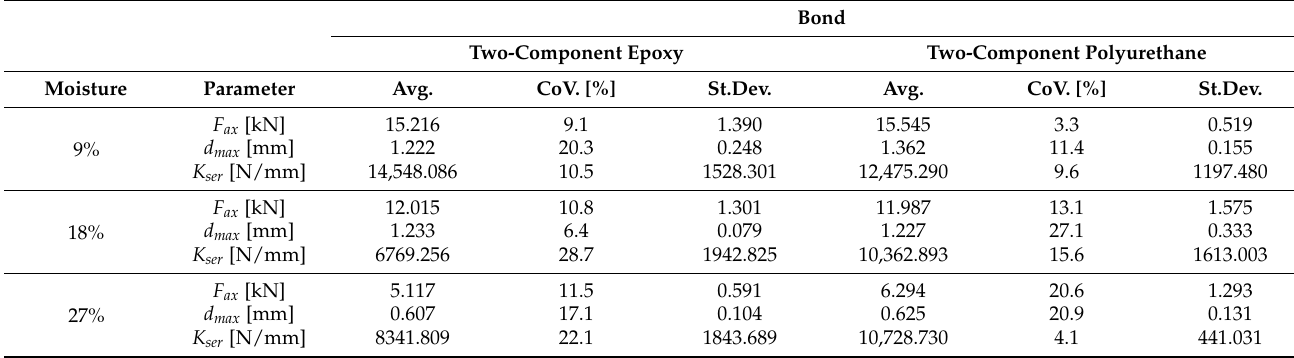
Table 3. Maximum axial force, displacement and slip modulus for specimens with parallel rod-to-grain arrangement (mean experimental values).